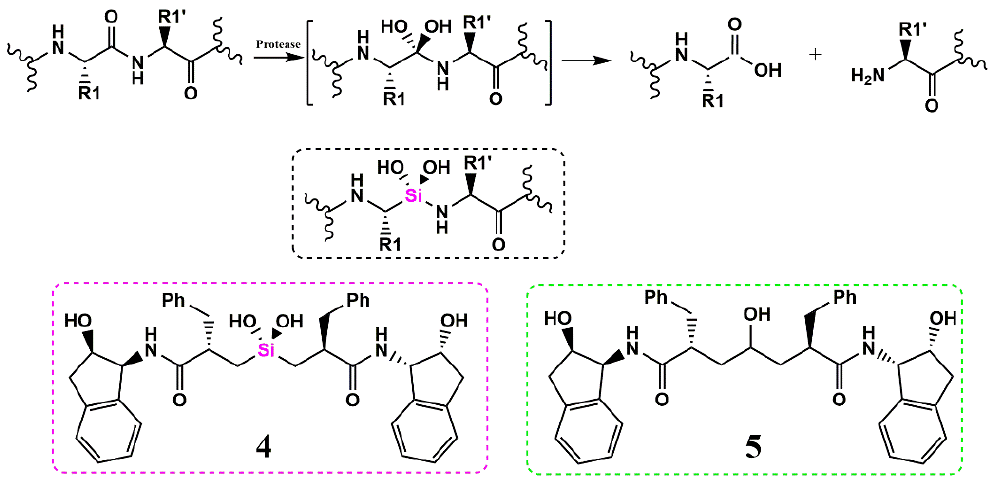
Figure 3. Proteolytic hydrolysis. The tetrahedral intermediate (in brackets) can be replaced by a non-hydrolyzable protease inhibitor (black dashed box).